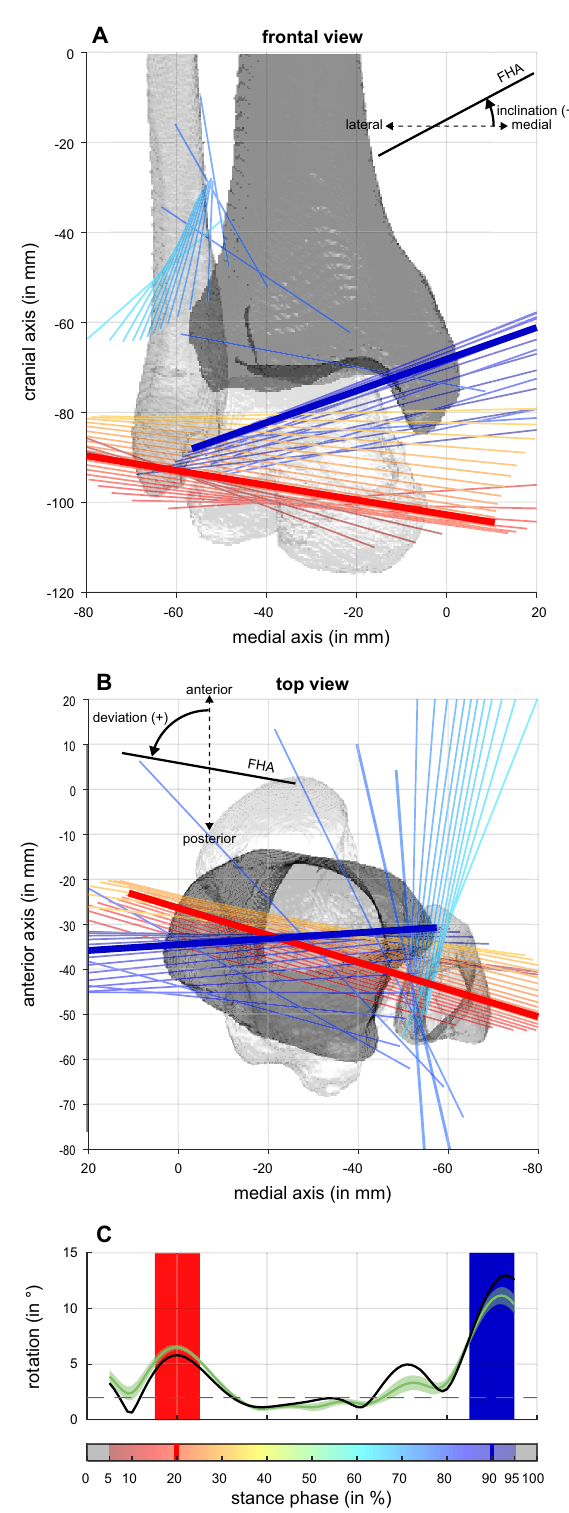
Figure 2. ( A ) Frontal view and ( B ) top view on ankle joint axes observed for an exemplary walking trial of Participant 3. Bones of the right lower limb are displayed in reference (standing position). Joint axes were estimated by finite helical axes calculated for two time points being 10% stance phase apart. Axes were only displayed when rotation about them was greater than 2 degrees (dashed line in C ). Color code of the axes matches the point in time of the stance they represent (see color bar in C ). Thicker lines correspond to axes determined for 20% (red) and 90% (blue) stance phase. ( C ) Rotation about finite helical axis shown for the exemplified trial (black line), the mean of all trials of Participant 3 (green line) and 95% confidence interval of the mean (green shaded area). Red area indicates the period of the stance phase considered as dorsiflexion movement, blue area as plantarflexion